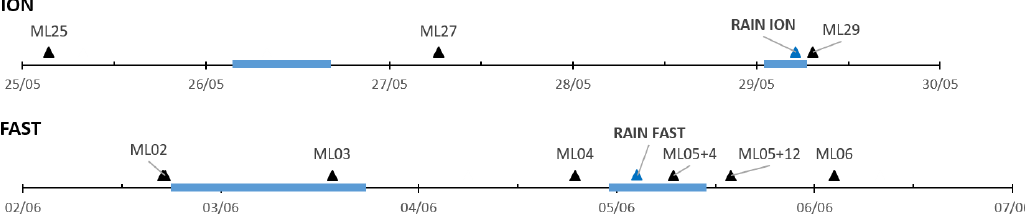
Figure 1. Sampling chronology during the ION and FAST stations for the ML and rains. The blue periods correspond to rainfall in the vicinity of the R/V position (from ERA 5 reanalysis and radar imagery; see Sect. 3.1.), and blue triangles correspond to the rainfall on the R/V position. Samplings were performed 4d (ML25) and 2d (ML27) before and 2h (ML29) after Rain ION and at a higher frequency at FAST, i.e. 57 (ML02), 37 (ML03) and 7.5 (ML04) hours before and 4.5 (ML05 + 4), 12 (ML05 + 12), and 24h (ML06) after Rain